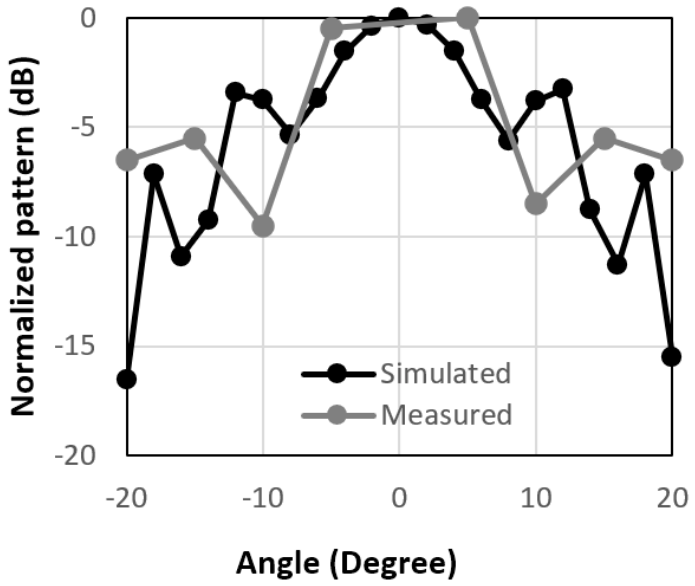
Figure 7. Normalized radiation patterns for circular patch with ring type of unit cells at 3.5 GHz.